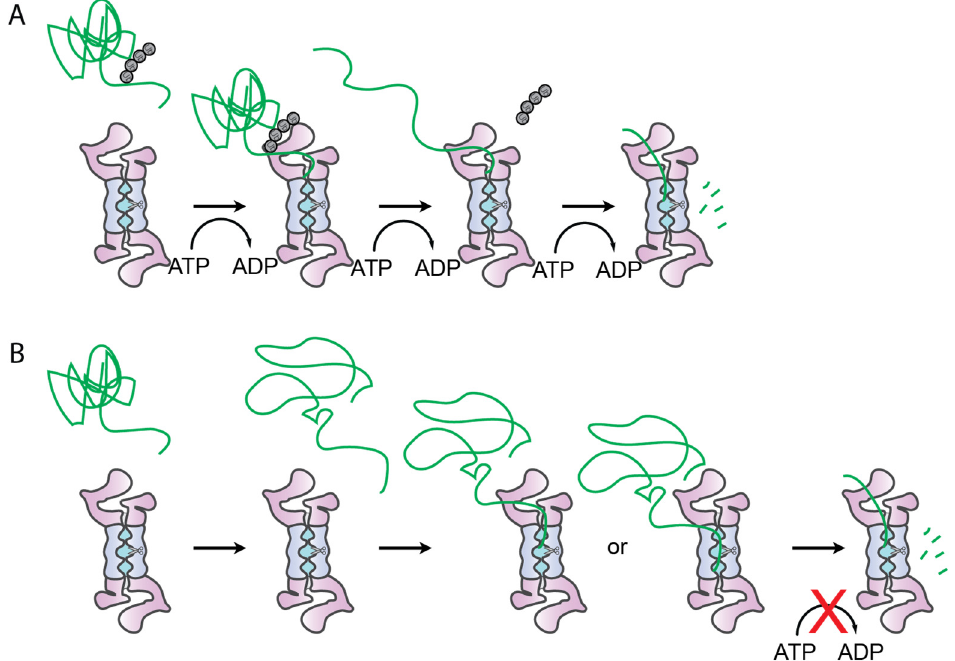
Figure 4. Mechanism of Ub-dependent versus UbID degradation by the proteasome. ( A ) Ubiquitin- dependent degradation occurs via ATP-dependent engagement, deubiquitination unfolding, and translocation. ( B ) Ubiquitin-independent degradation requires transient unfolding of the substrate, which is then captured by the 20S in an ATP-independent manner. It is unknown if the substrate still enters via the 19S pore.